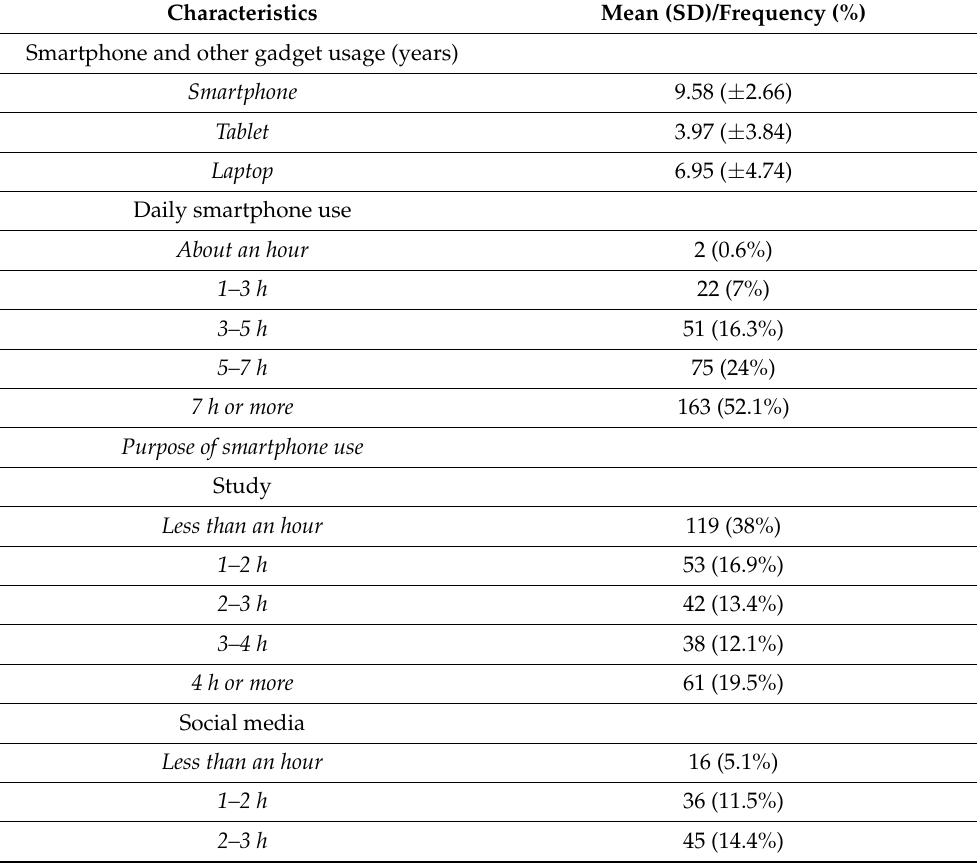
Table 2. Smartphone usage of the participants.